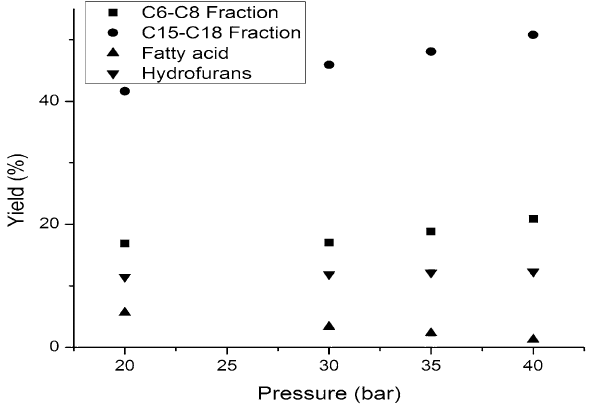
Figure 10. The influence of temperature over the yields in products composition of liquid organic phase.